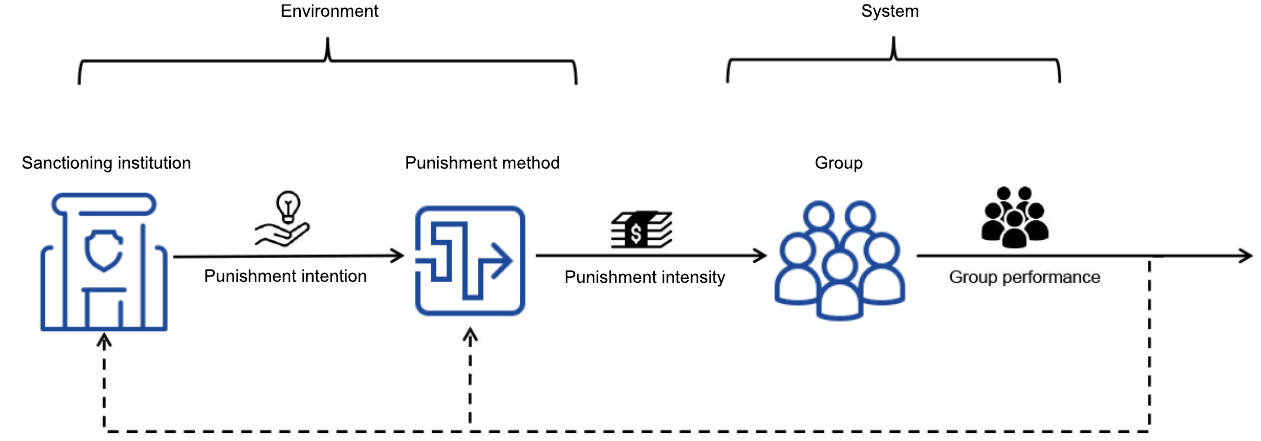
Figure 1. Sanctioning institutions steer the group through punishment